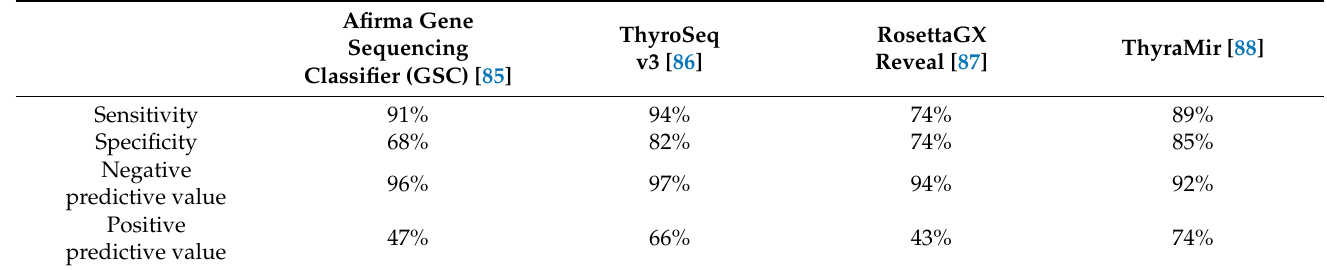
Table 4. Clinical validation studies results of commercially NGS used in patients with indeterminate FNAC (adapted from Agarwal et al. [84]).